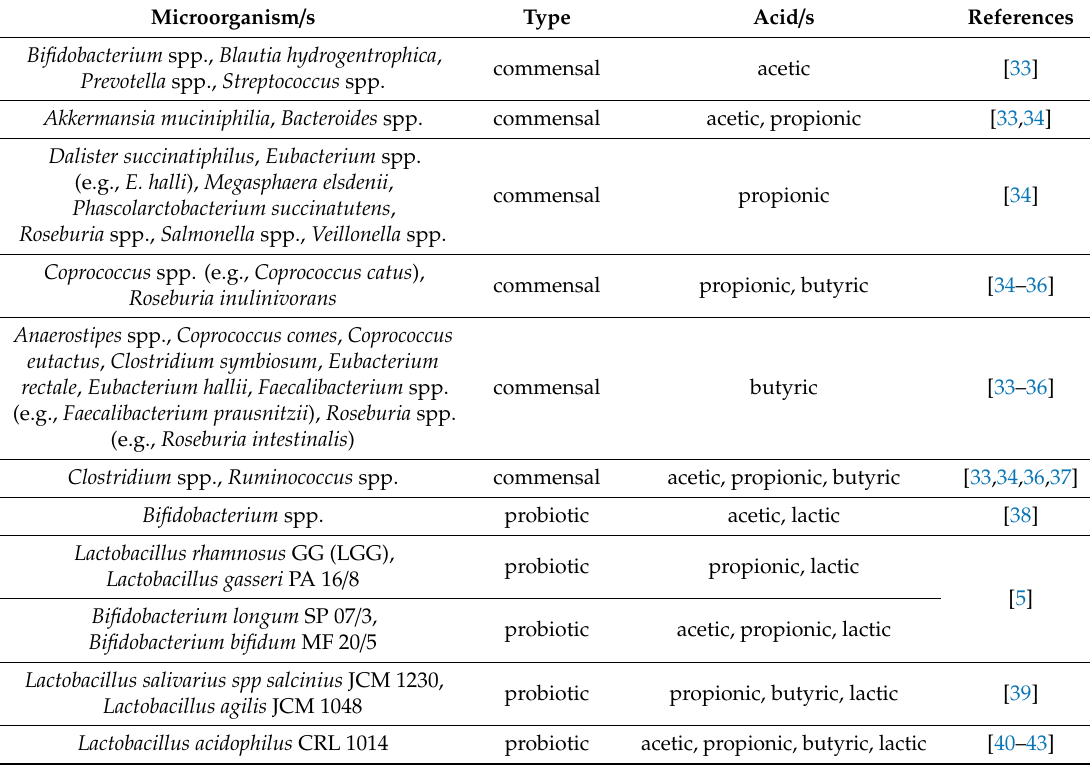
Table 2. Examples of commensal and probiotic microorganisms producing SCFAs and lactic acid [5]. Microorganism /